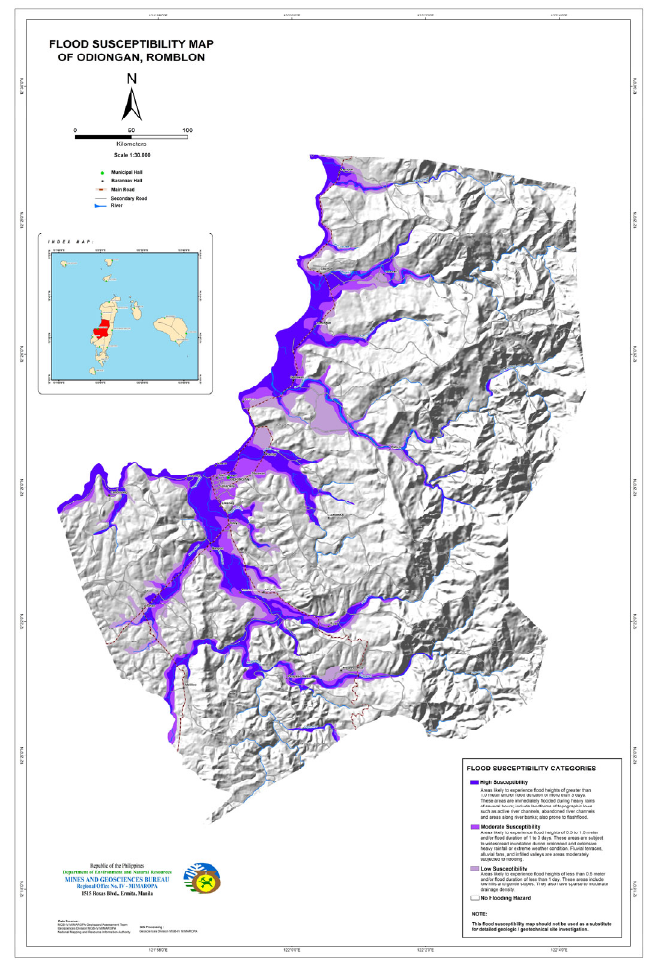
Figure A1. Flood Susceptibility Map from MGB ‐ DENR.